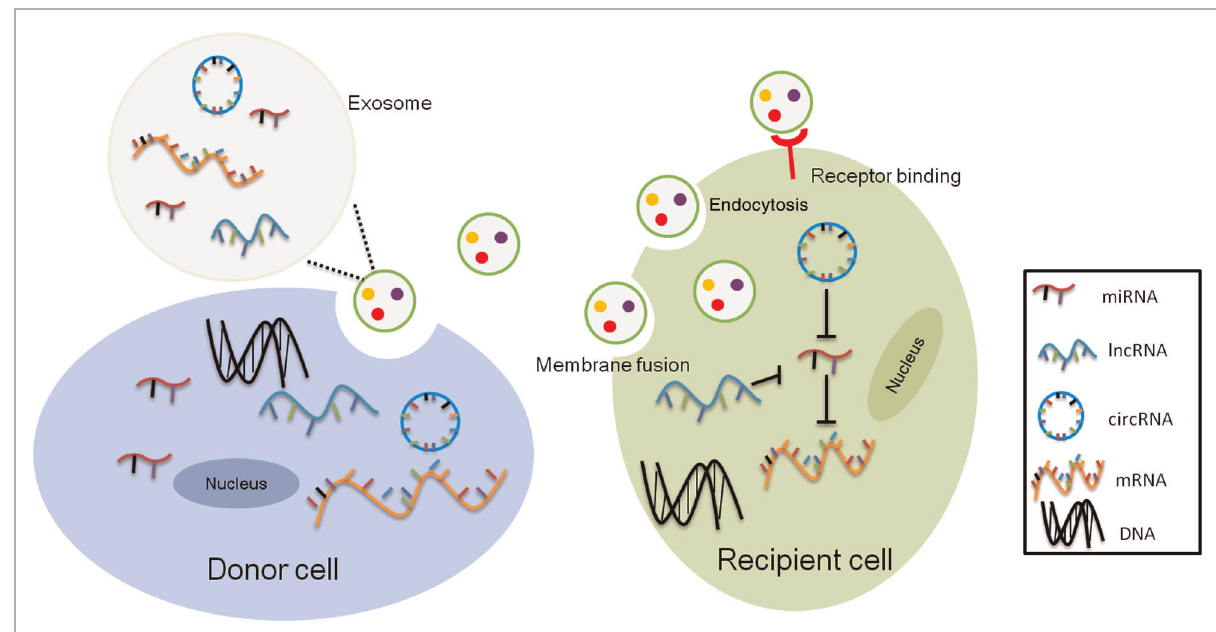
FIGURE 1 Intercellular transcriptomes delivery by exosomes. Exosomal noncoding RNAs, mainly microRNAs (miRNAs), long noncoding RNAs (lncRNAs), and circular RNAs (circRNAs) from donor cells act as competitive endogenous RNAs (ceRNAs) for binding to common miRNA response elements (MREs) from recipient cells altering their